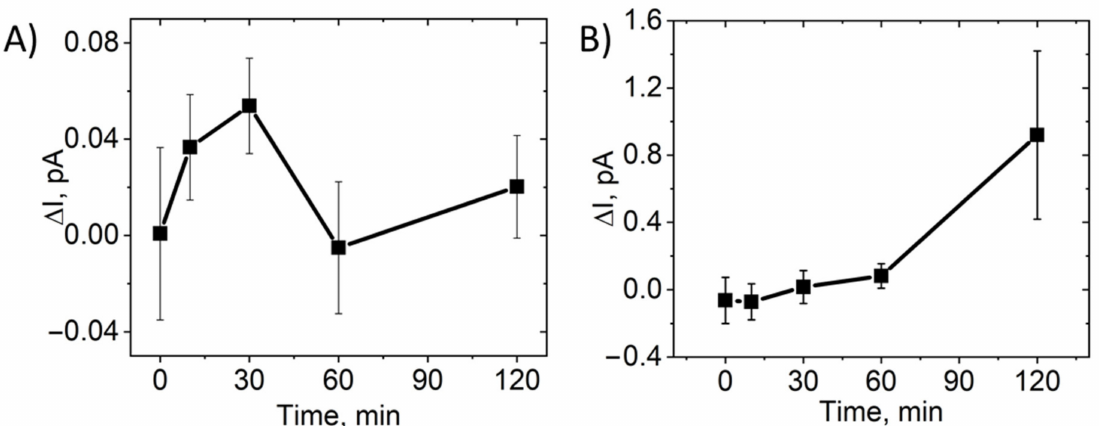
Figure 5. Dynamics of the H 2 O 2 level in rabbit tears and intraocular fluid after a single instillation of Nano-SOD1. The data are presented as mean ± SEM for 5 rabbits. The current is proportional to hydrogen peroxide concentration. The H 2 O 2 dynamics were calculated as the difference between the left (experimental) and right (control) eyes of each animal in tear ( A ) and intraocular fluid ( B